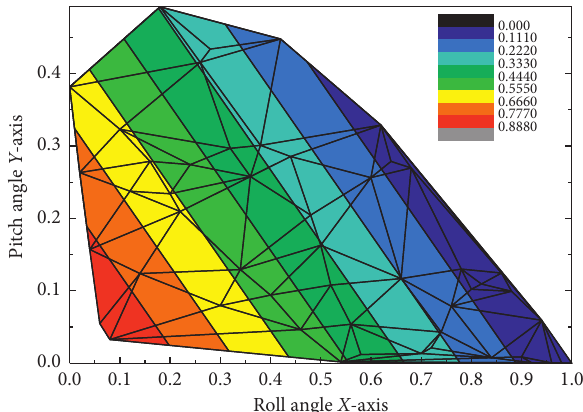
Figure 3: Running and walking posture